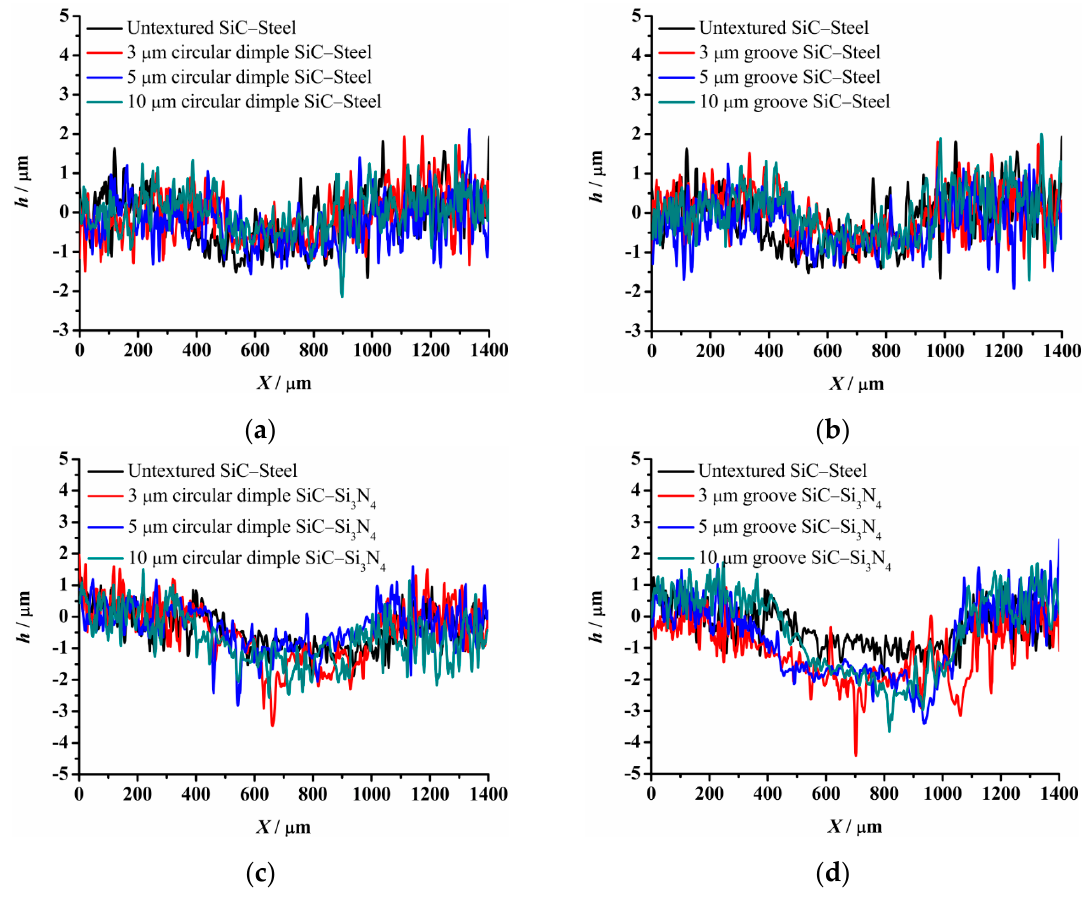
Figure 18. Cross section of wear scars under water-lubricated conditions with a load of 75 N: ( a ) circular-dimple-textured SiC–steel ball, ( b ) groove-textured SiC–steel ball, ( c ) circular-dimple-textured SiC–Si 3 N 4 ball, and ( d ) groove-textured SiC–Si 3 N 4 ball.